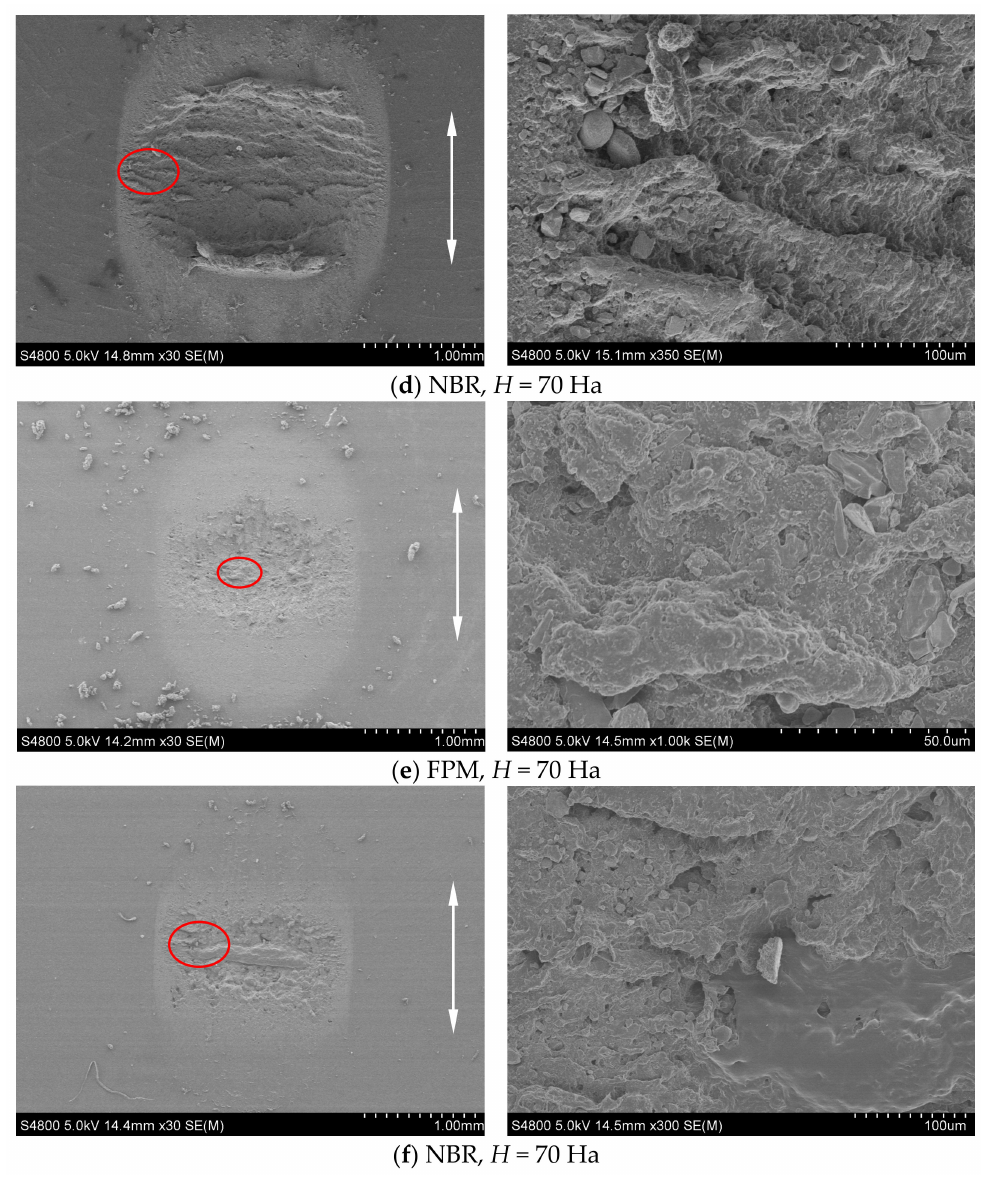
Figure 10. The SEM morphology of three rubbers under F n = 5N, d = ± 0.45mm, and f = 10Hz (left: the whole contact region; right: the local